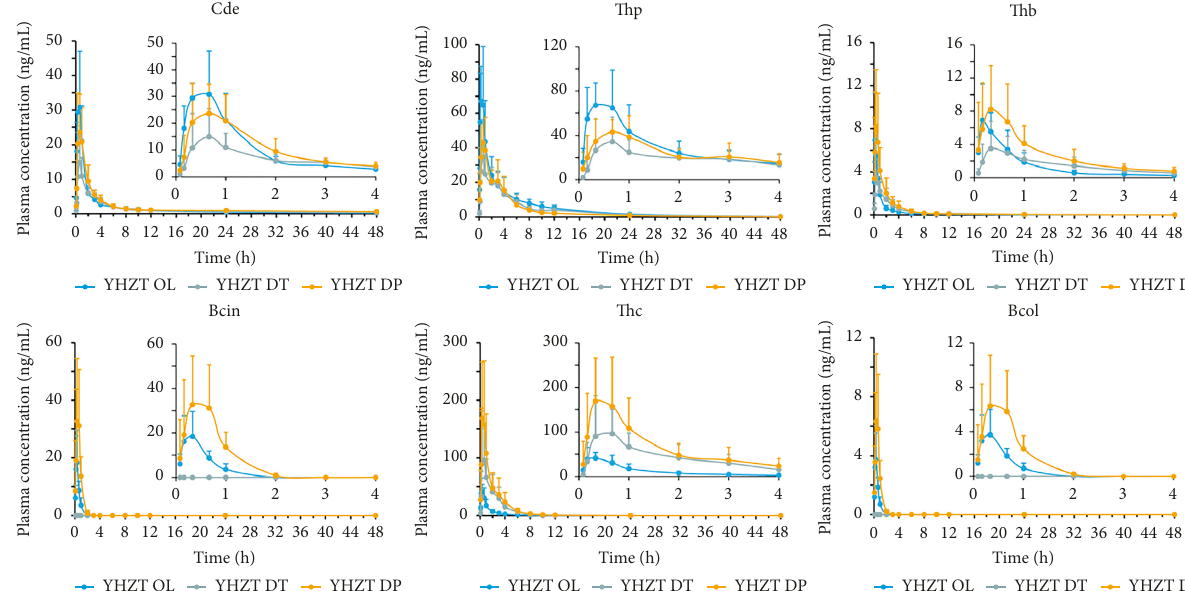
Figure 4: Mean plasma concentration-time curve of the analytes in dog plasma after oral administration of YHZT OL, DT, and